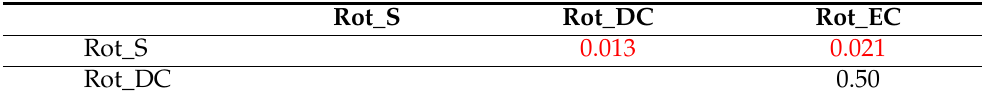
Table A3. Pairwise Wilcoxon rank sum test results for No_navigation_error. The number is marked red when it is statistically significant ( p < 0.05)